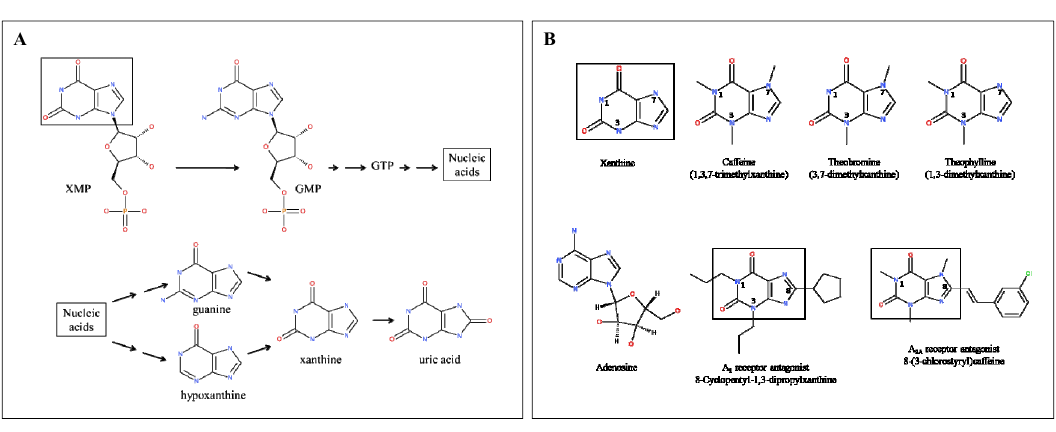
Figure 1. ( A ) Xanthine as an intermediate of GTP and nucleic acid anabolism and catabolism. Rectangles in compounds highlight the xanthine unit; ( B ) Structures of methylxanthines, adenosine, and adenosine receptor antagonists structurally related to methylxanthines. Rectangles in compounds highlight the xanthine